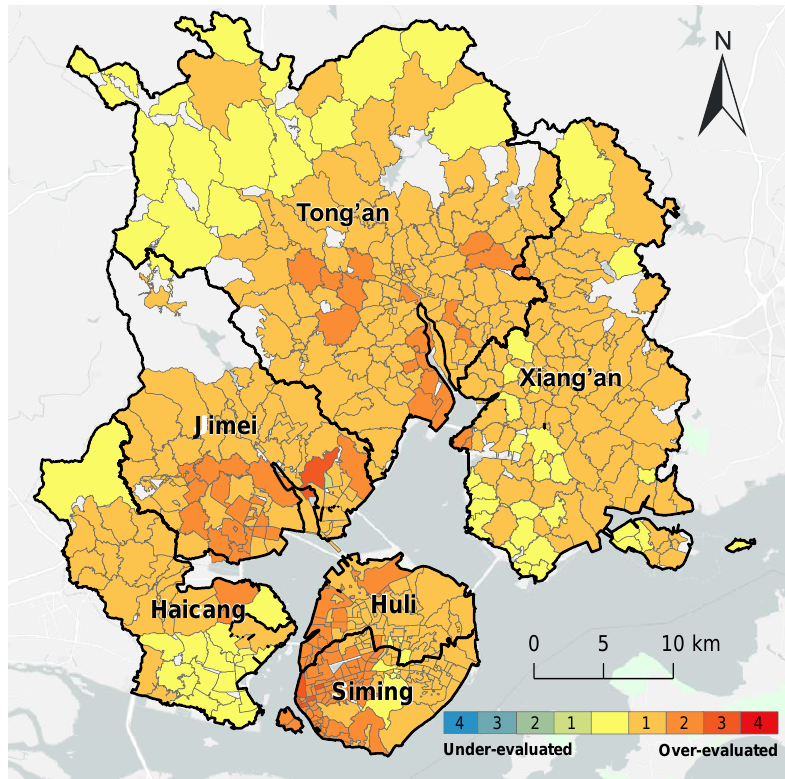
Figure 12. Comparison of the accessibility of pediatric services with the overall spatial accessibility in Xiamen City.